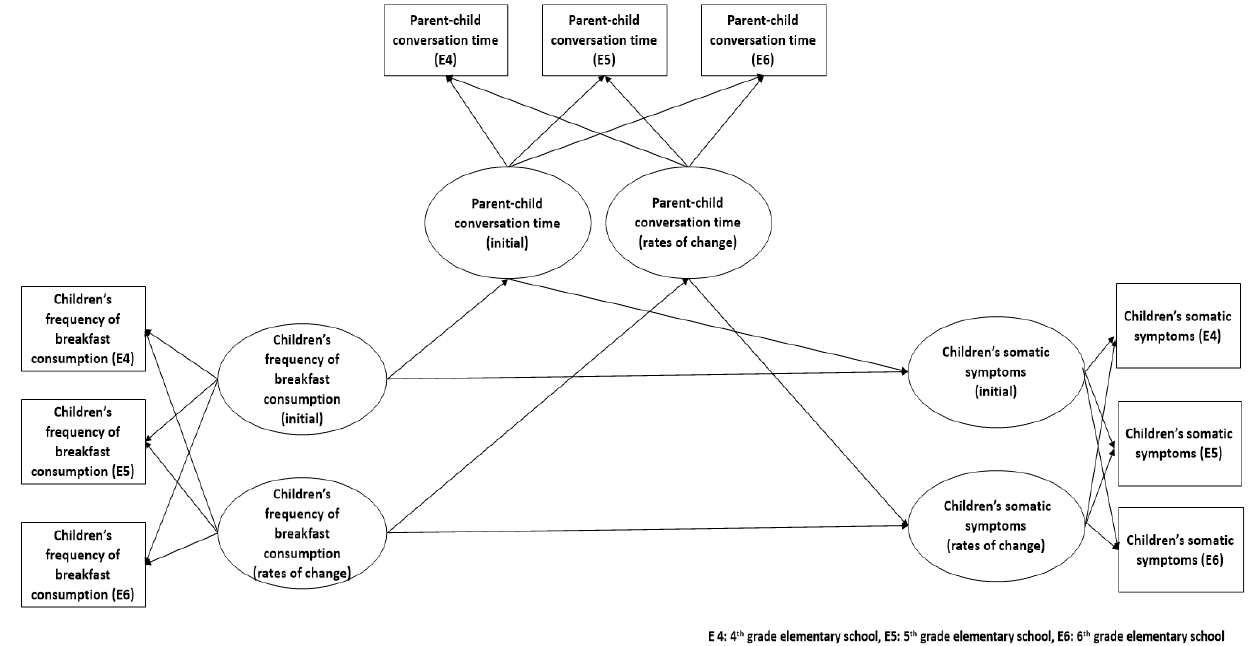
Figure 1. Research Figure 1. Research model.